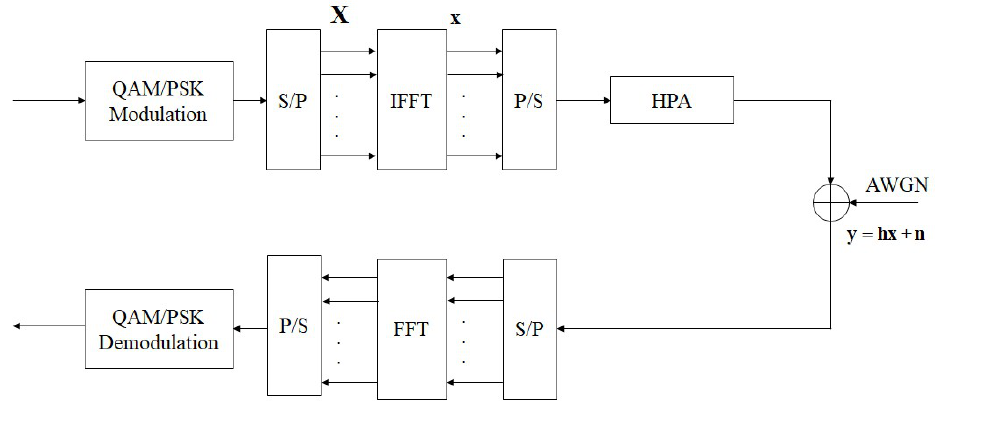
Figure 1. The block diagram of the fundamental of the OFDM